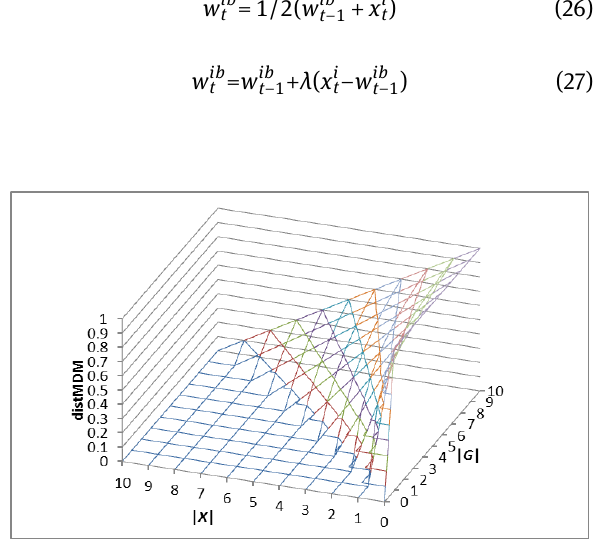
Figure 2: dist MDM (︀ X t , G k )︀ against the magnitude of two vectors of interest (plotted for |G|>|X| only for clarity).